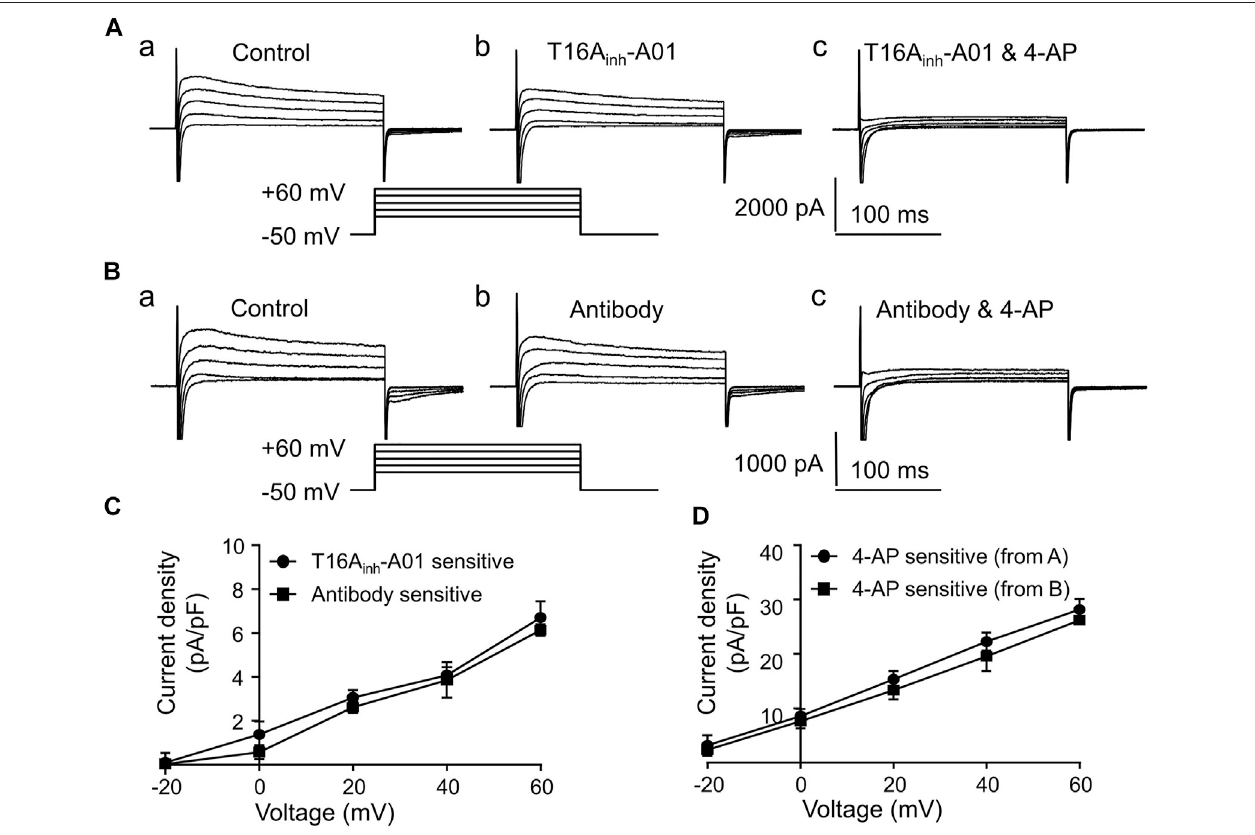
FIGURE2| I to inLVMs. (A) RecordingsshowtheeffectsofT16A inh -A01(30 μ M)or4-AP(5 mM)onI to inLVMs. (B) RecordingsshowtheeffectsofAnti-TMEM16A antibody(1:200)or4-AP(5 mM)onI to inLVMs. (C) I-VrelationsofT16A inh -A01sensitivecurrentandAnti-TMEM16Aantibodysensitivecurrent( n =4cellsineachgroup, two-way ANOVA). (D) I-V relation of 4-AP sensitive current ( n = 4 cells in each group, two-way